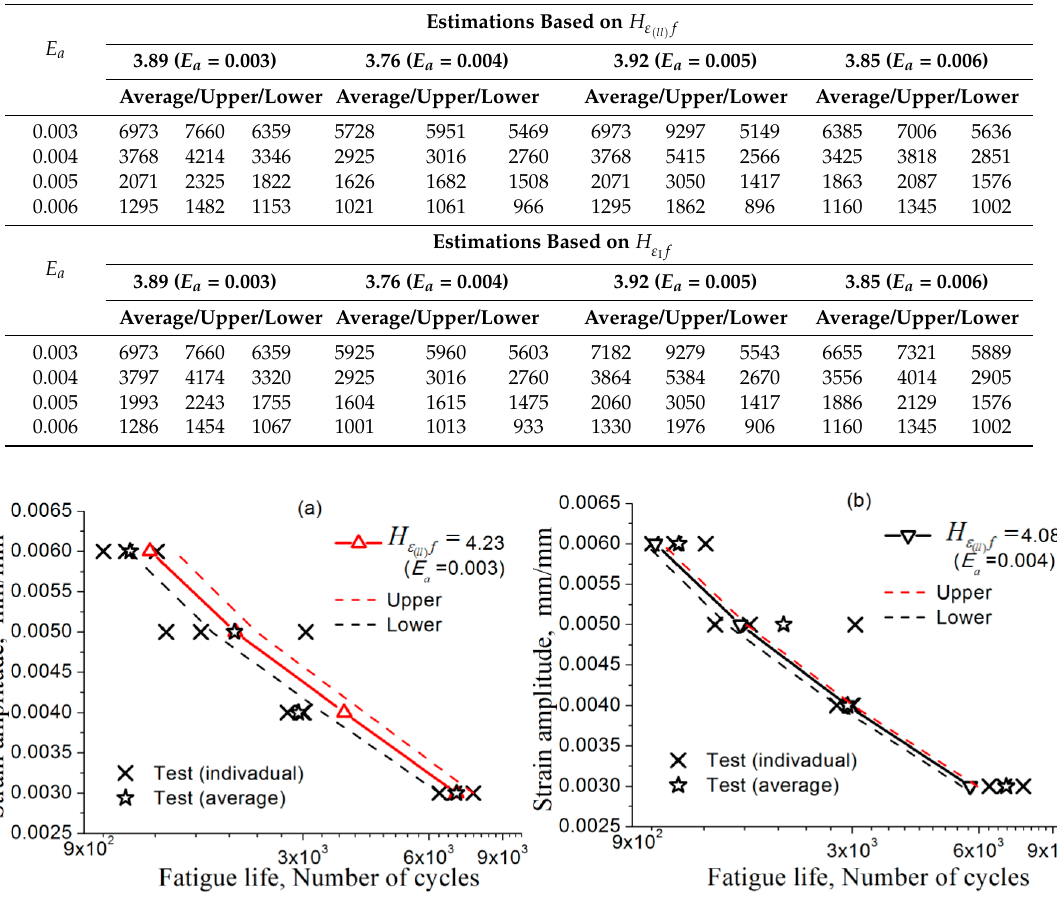
H H as FIP. and H ε as FIP. ε and ε ( ll ) 1 )( ll 1